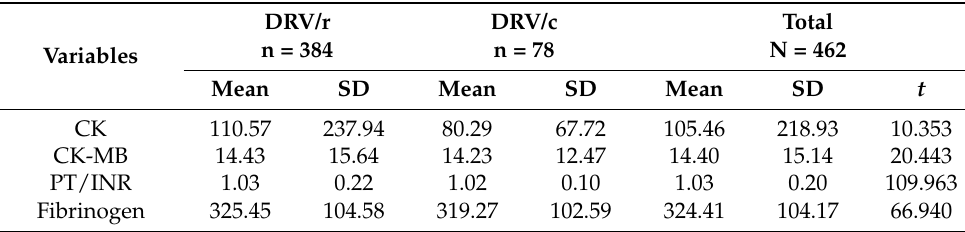
Table 7. Descriptive statistics of cardiac and coagulation markers ( p < 0.01).